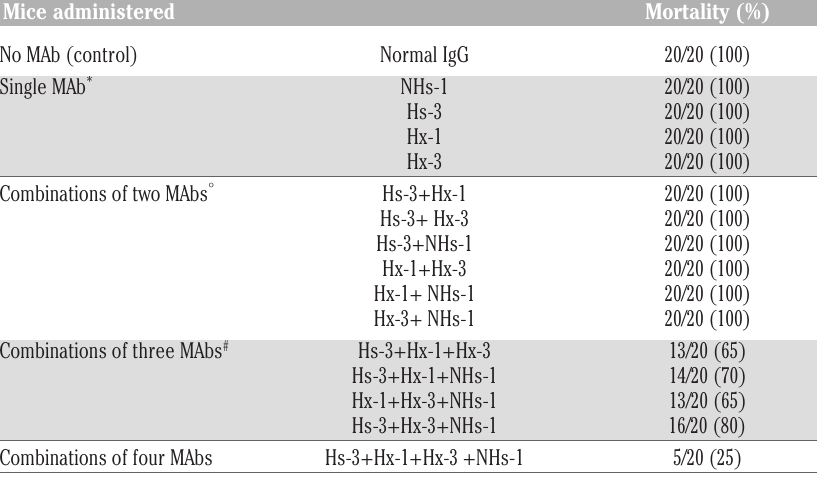
Table 2. Mortality of Japanese encephalitis virus (strain 691004)-infected mice passively given single monoclonal antibodies to Japanese encephalitis virus glycoprotein E and their